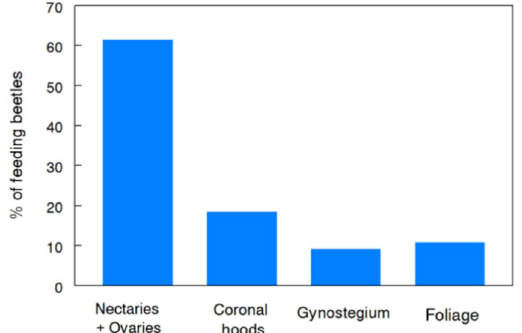
Figure 4. Frequency distribution of Japanese beetles [JB] feeding on floral organs or foliage of A . syriaca in choice tests. Flowers were dissected into component parts: nectaries + ovaries (on pedicel), coronal hoods, gynostegium (stigmatic chambers + pollinaria) and offered to individual females (n = 80) in four-way choice tests that included a 1 cm 2 piece of leaf tissue. Food choice of JB that fed (n = 65) differed significantly from the null hypothesis of no preference ( χ 2 = 47.6, df = 3, P < 0.001).